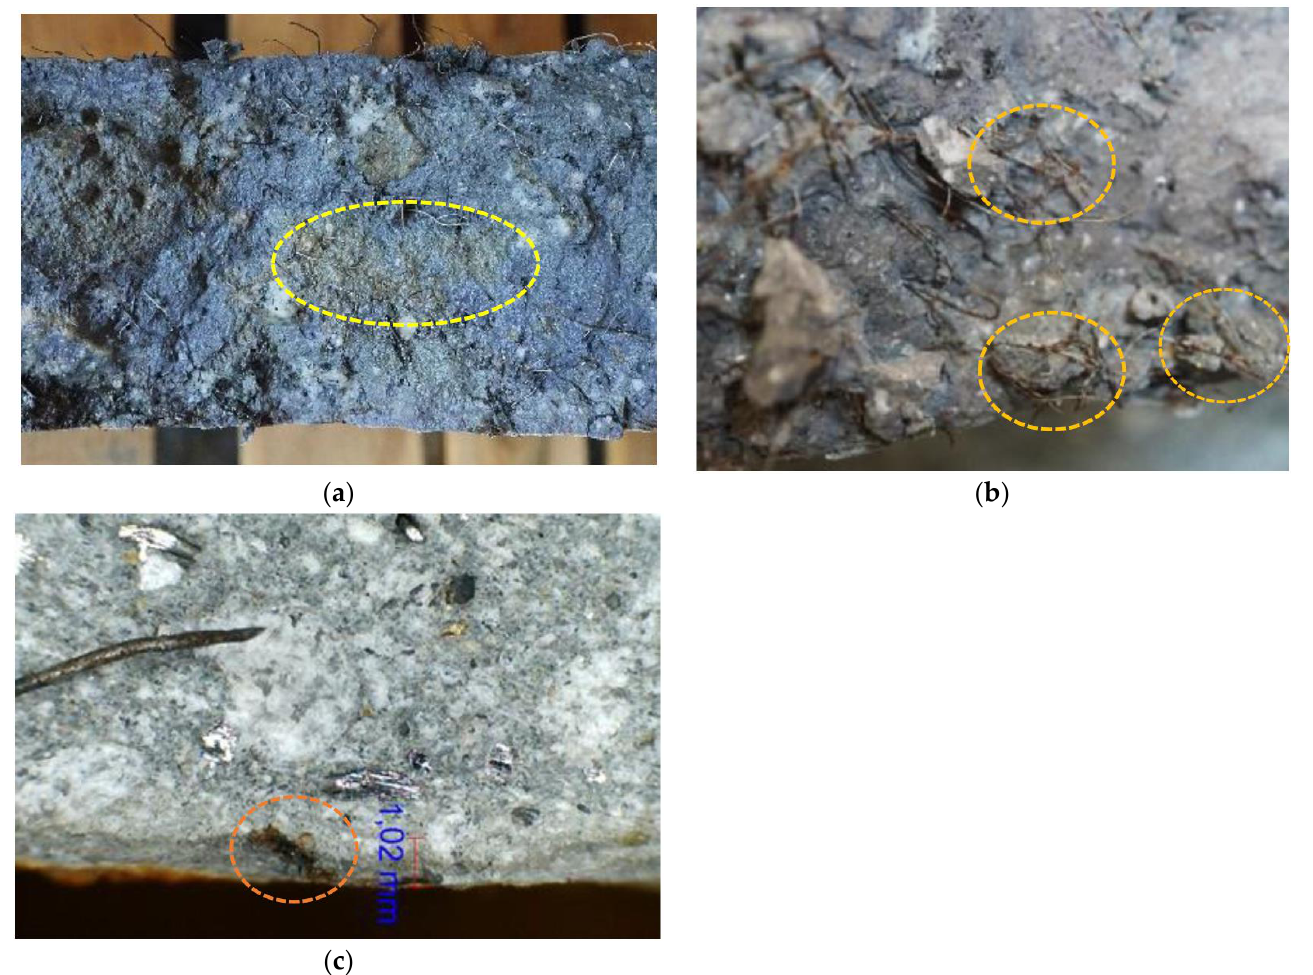
Figure 6. ( a ) Inspection of recycled steel fibers’ (RSFs) corrosion at the crack surface; ( b ) chloride penetration depth at the cracked surface; and ( c ) corrosion signs on RSFs located on an orthogonal cut plane to a crack surface (uncracked region), after the exposure period of 90 days of dry–wet cycles.